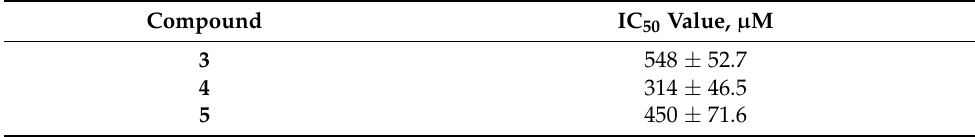
Table 3. IC 50 values for compounds 3–5 on BJ tert human